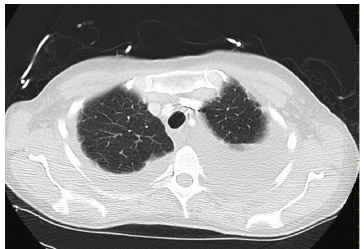
Figure 1: CT scan of the chest showing bilateral pleural effusions.